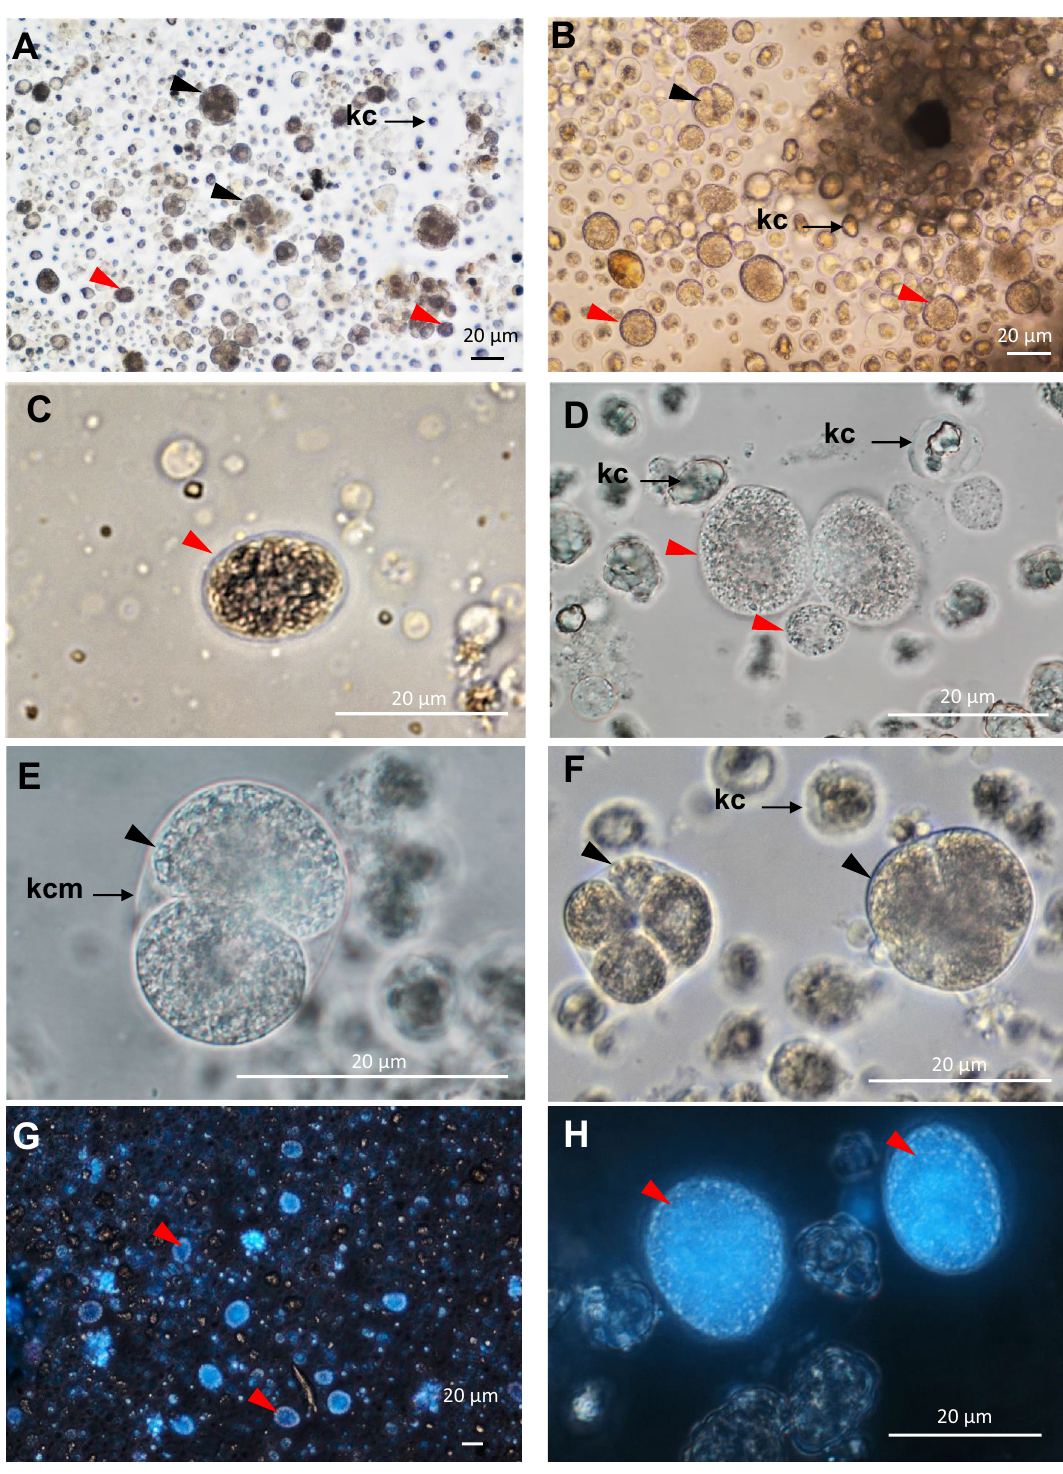
Figure 5. Micrographs of unstained ( A to F ) and stained (with DAPI, G and H ) fresh kidney preparations. Red and black arrowheads represent single and dividing BSM, respectively. Letters indicate kidney cell membrane (kcm), kidney concretions